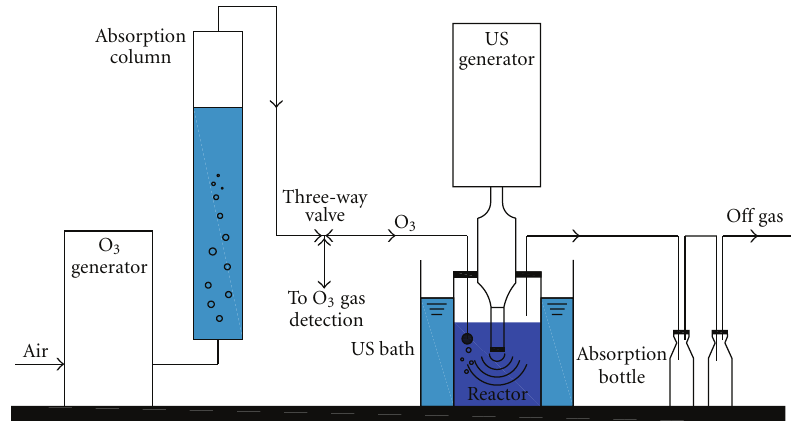
Figure 1: Laboratory-scale experimental setup for the degradation of diclofenac through ozonation/sonolysis.